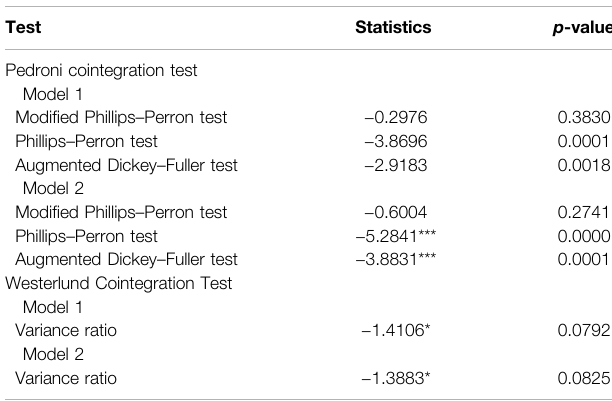
TABLE 3 | Slope heterogeneity.